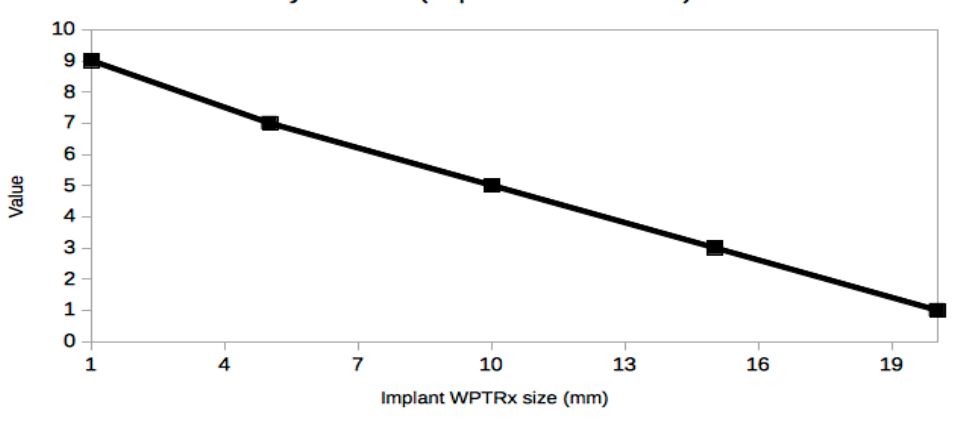
Figure 6. Utility function for Implant WPTRx Size.